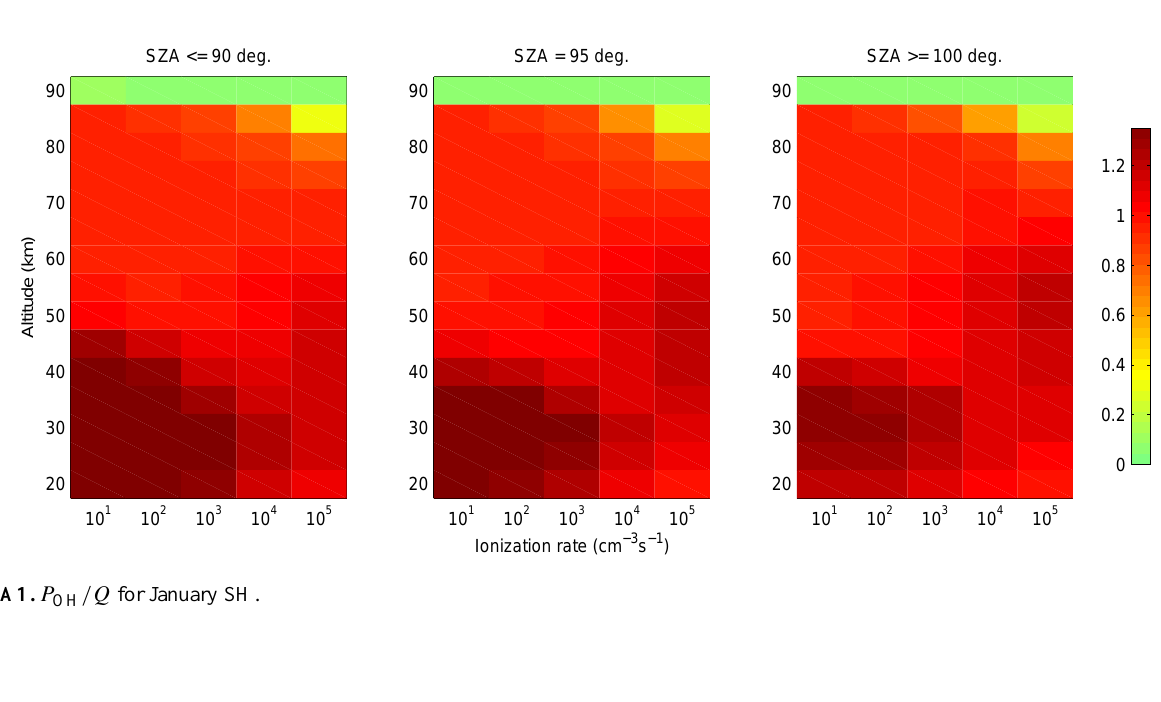
Fig. A1. P OH /Q for January